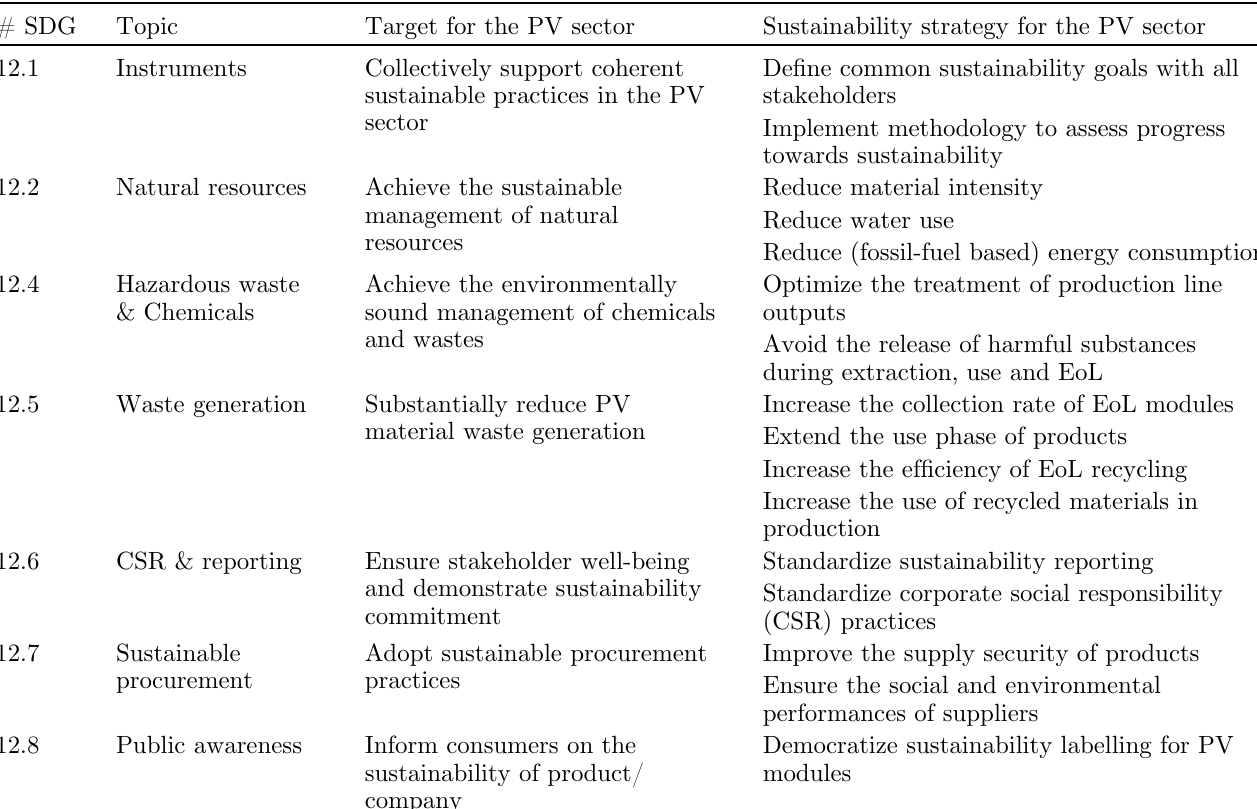
Table 1. Sustainability targets and strategies for the PV sector under the lens of SDG 12